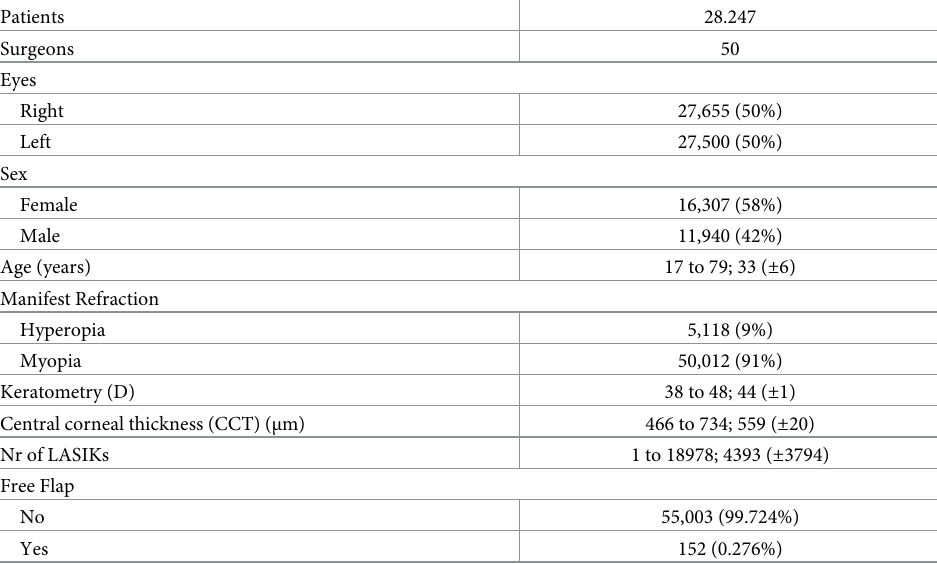
Table 1. Demographics of free flap